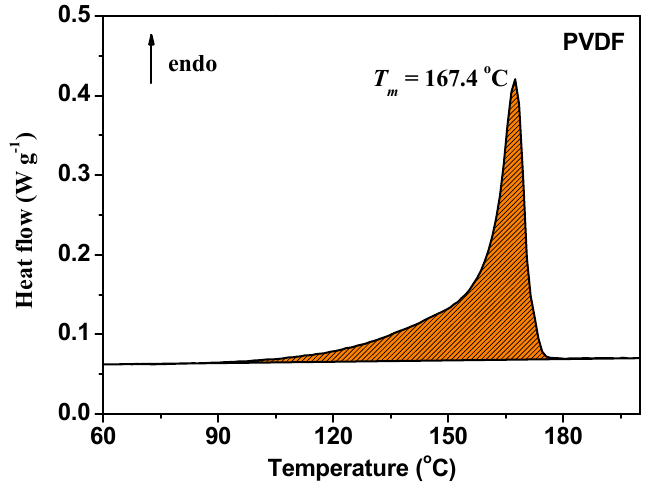
Figure 7. DSC curve of the electrospun PVDF membrane.